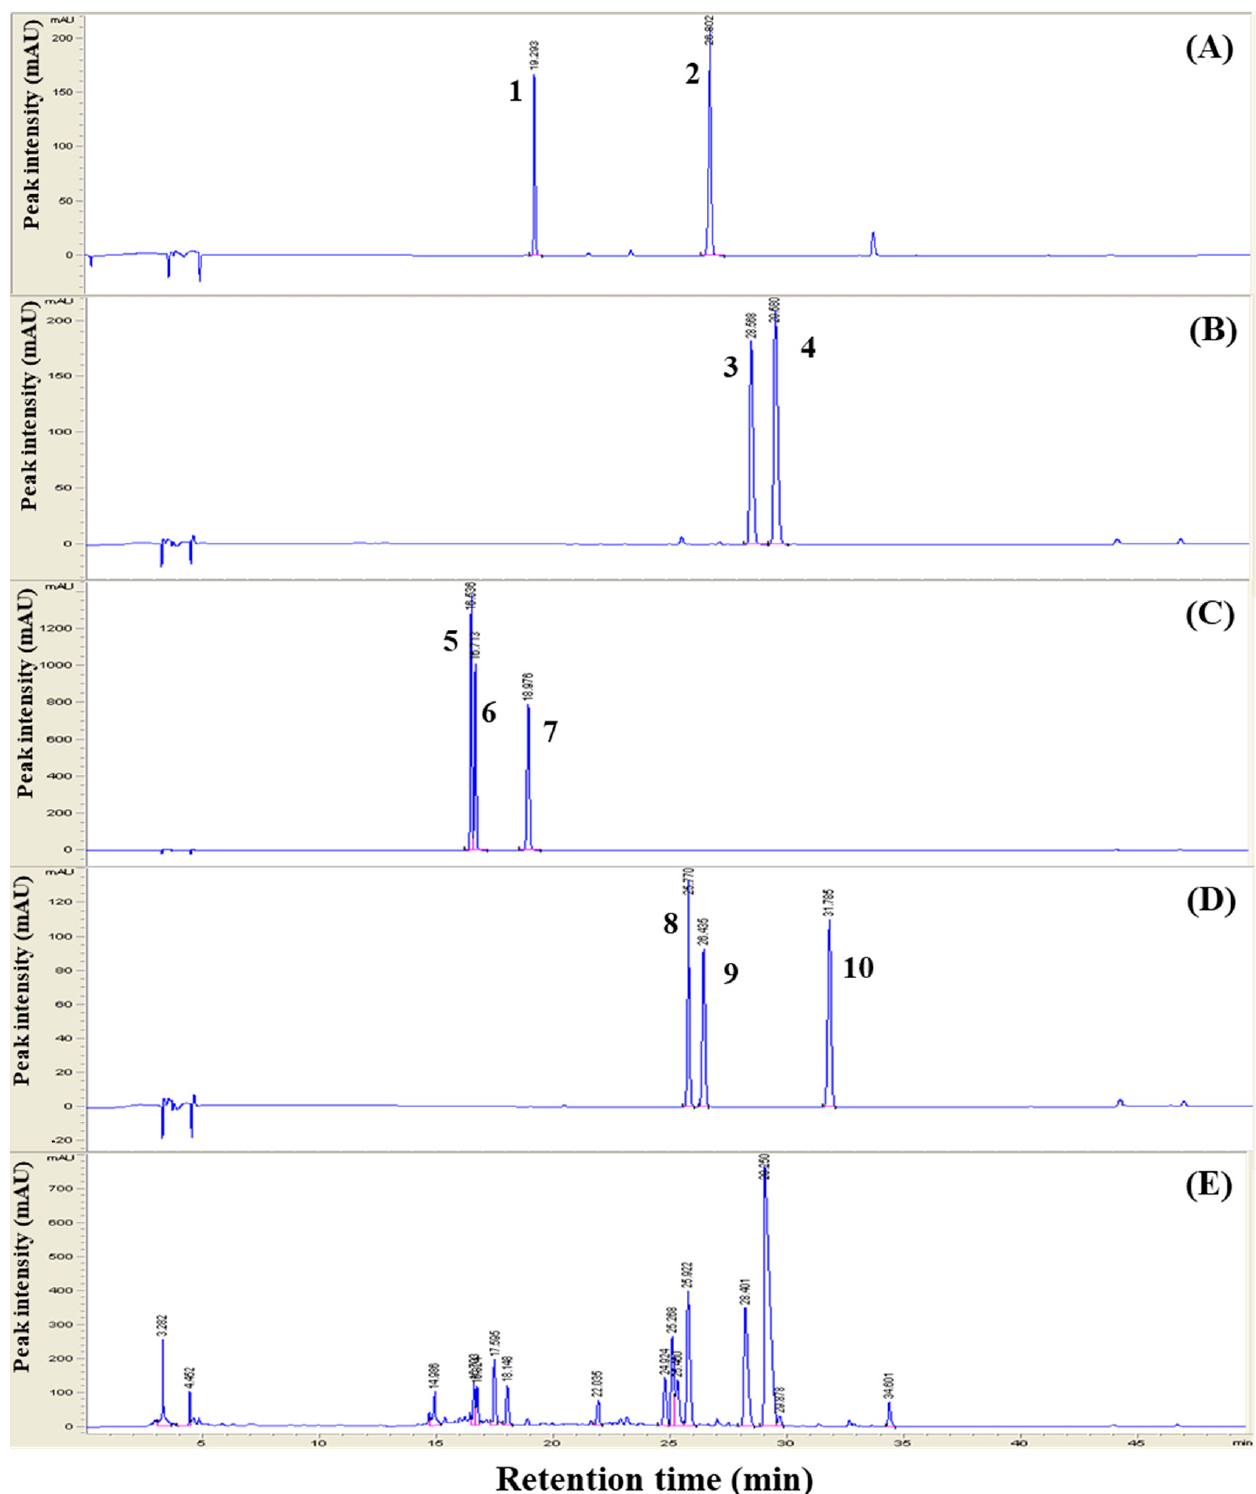
Figure 1. The high-performance liquid chromatography profile of Three Herb (3Hb) and 3Hb extract 3Hb means Rhizome of Coptis chinensis , Rhizome of Glycyrrhiza uralensis , and fermented Semen of Glycine max . Markers were eluted in the standard solution ( Rhizome of Glycyrrhiza uralensis ( A ), Rhizome of Coptis chinensis ( B ), fermented Semen of Glycine max ( C , D )), 3 Hb extract ( E ). Peak number: markers of liquiritin (1), liquiritigenin (2, berberine (3), palmatine (5) and isoflavones such as daidzein (5), glycitein (6), genistein (7), daidzin (8), glycitin (9), and genistin